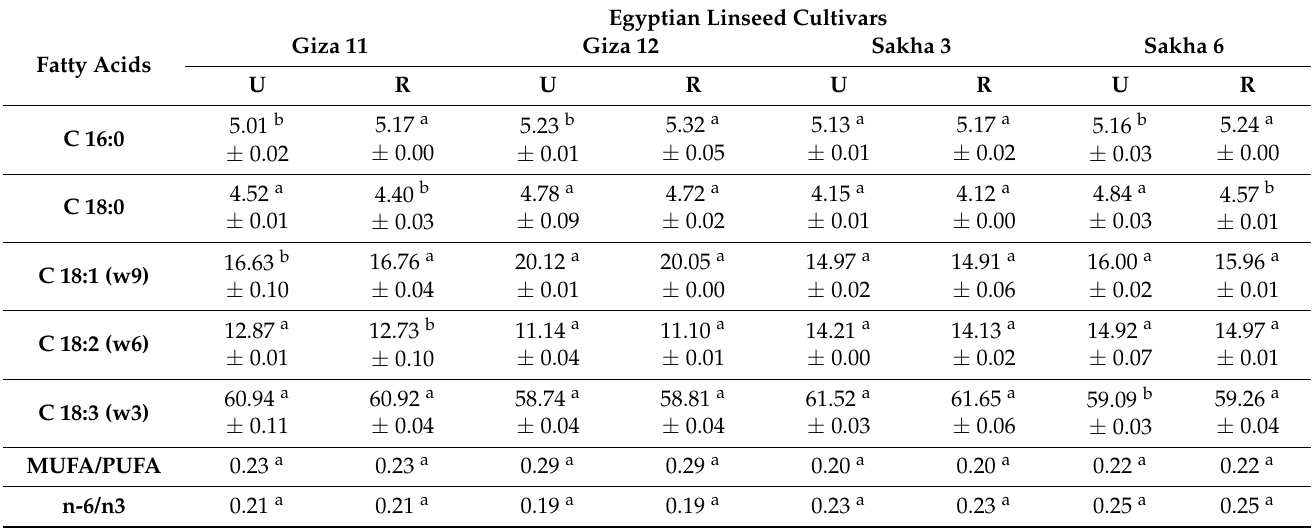
Table 4. Fatty acid composition of oil extracted from four Egyptian unroasted and roasted linseed varieties